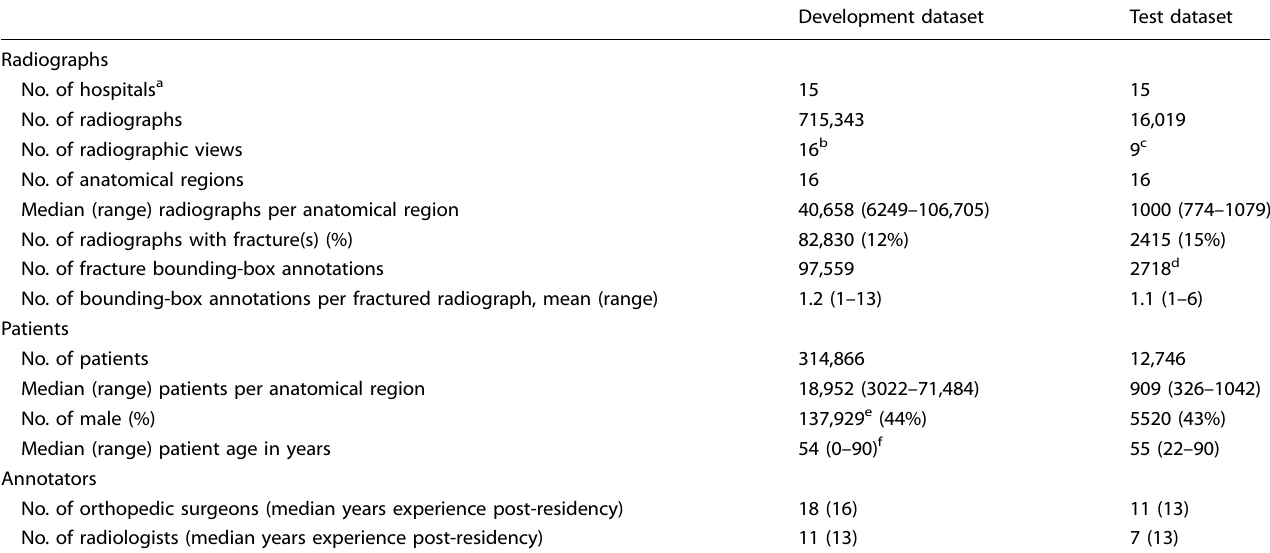
Table 1. Characteristics of the development and test